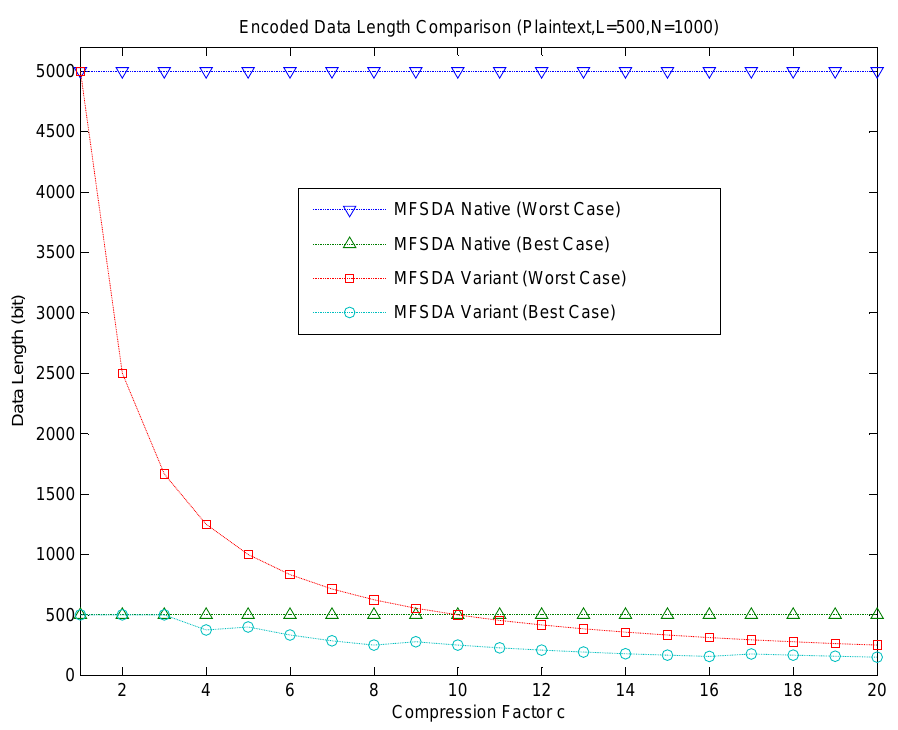
Figure 4. Communication cost comparison of MFSDA-I and